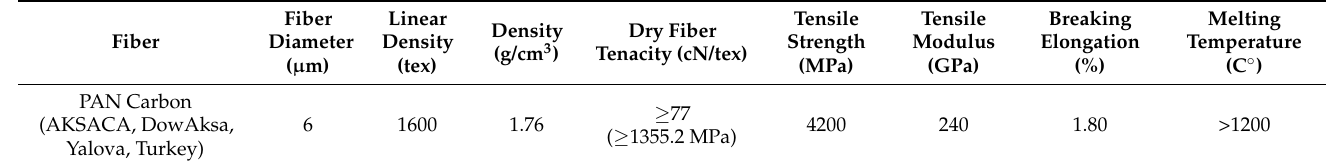
Table 1. Specifications of continuous carbon fiber utilized in the concrete composites